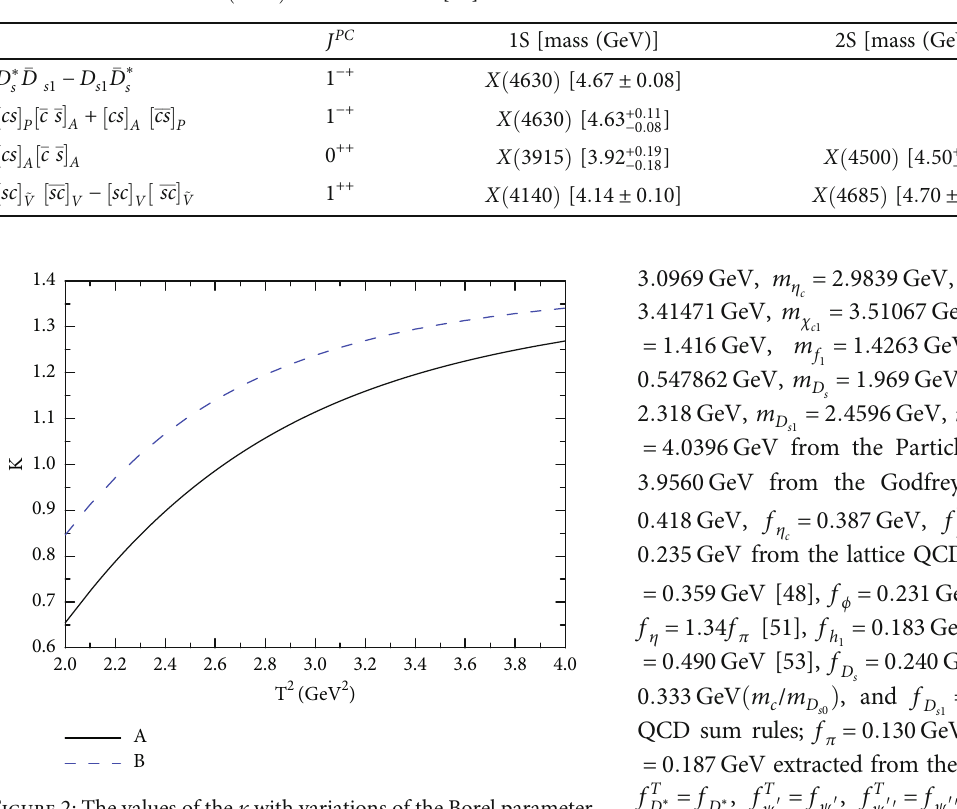
Table 3: The possible assignments of the LHCb ’ s X states based on the predictions from the QCD sum rules, where the superscript ∗ denotes the mass of the X ð 4140 Þ taken from Ref.